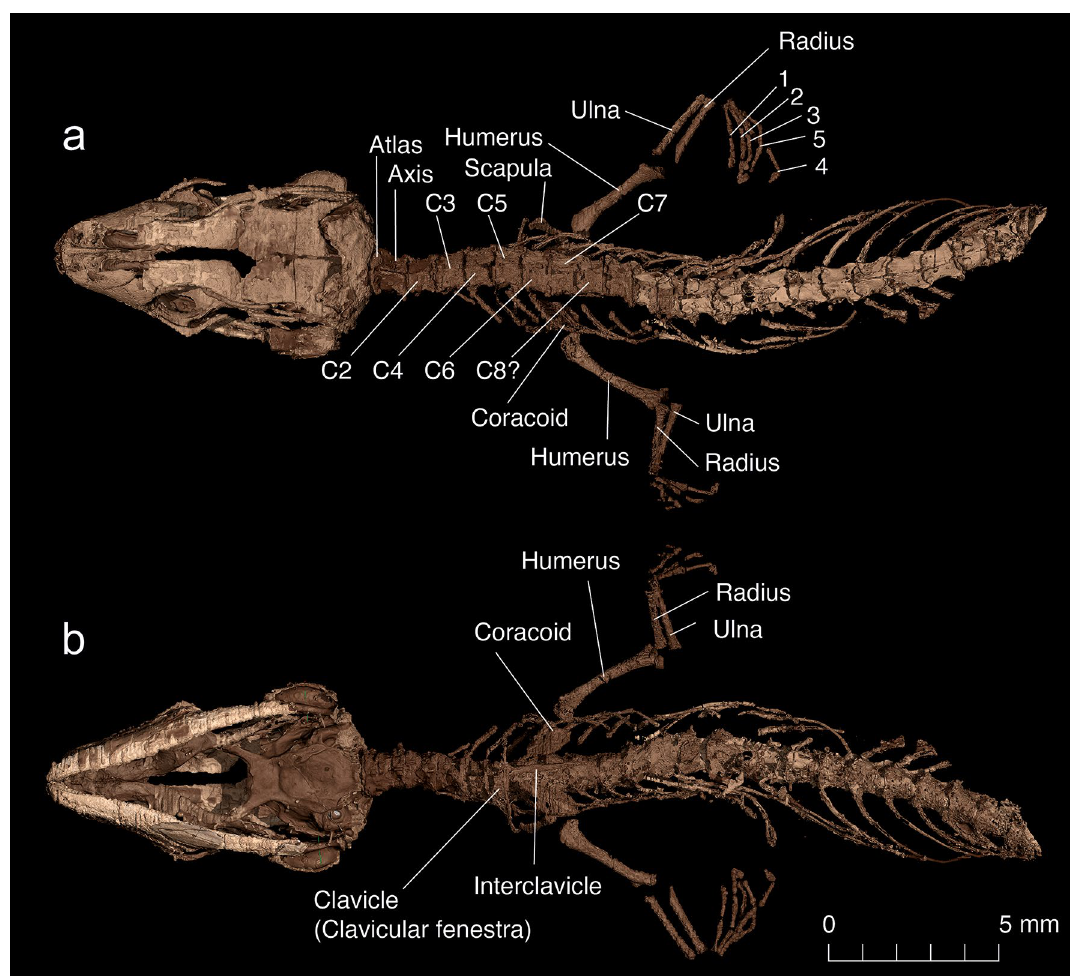
Figure 2. ( a ) Dorsal and ( b ) ventral views of Retinosaurus hkamtiensis (GRS 29689). The images show the skeleton of the specimen after removing the calcified material within the